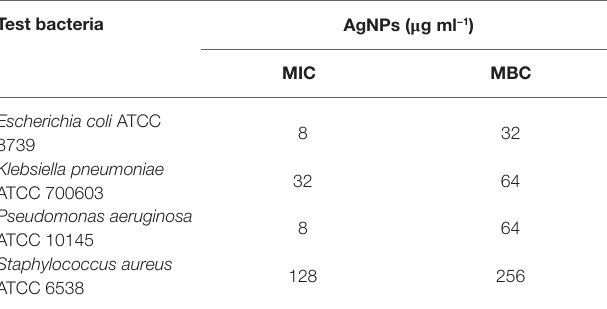
TABLE 1 | Minimum inhibitory concentrations (MICs) and minimum biocidal concentrations (MBCs) of AgNPs ( μ g ml −1 ). Test